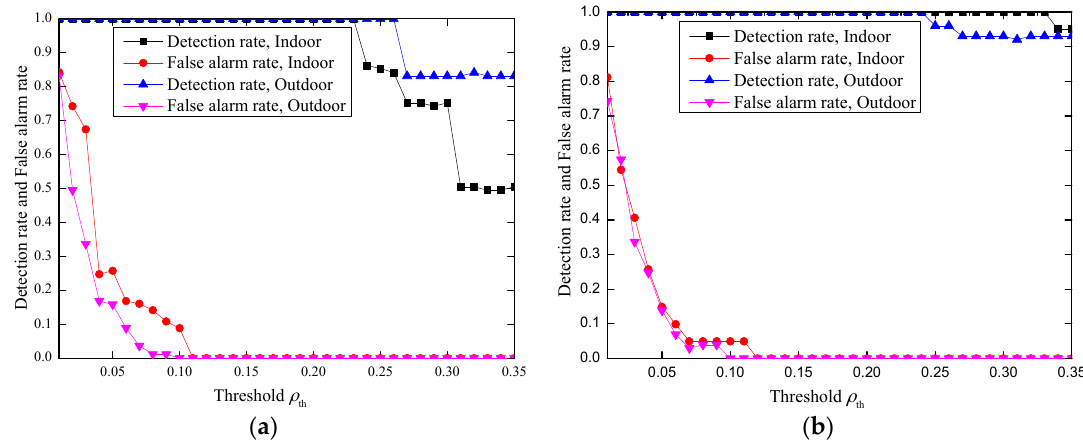
( a ) ( b ) Figure 7. The average false alarm α and detection rate β with | ρ | > 0.2 and | ρ | > 0.3. ( a ) | ρ | > 0.2; ( b ) | ρ | >